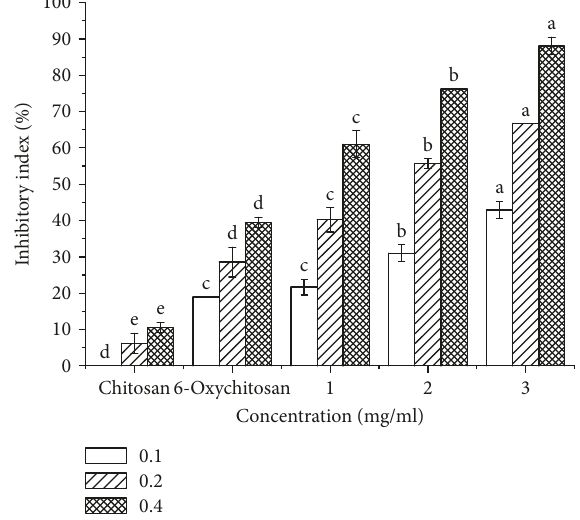
Figure 3: The antifungal activity of chitosan, 6-oxychitosan, 1, 2, and 3 against V. albo-atrum.